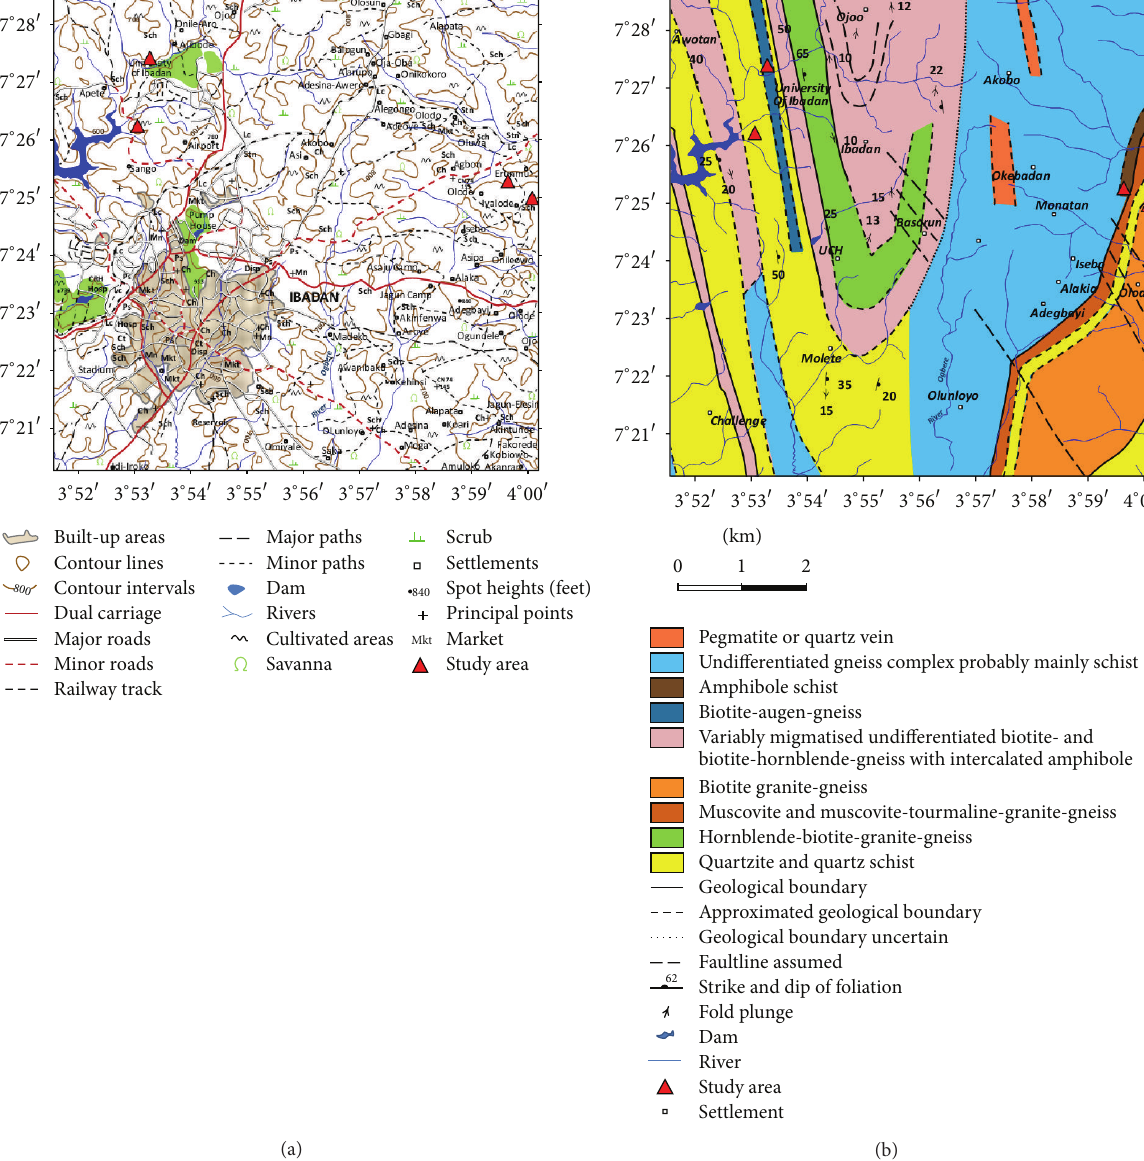
Figure 1: (a) Location map of Ibadan showing the study area. (b) Geological map of Ibadan [10].